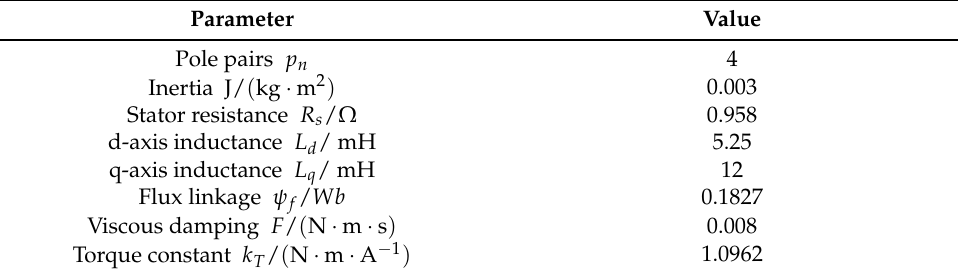
Table 4. Parameters of the